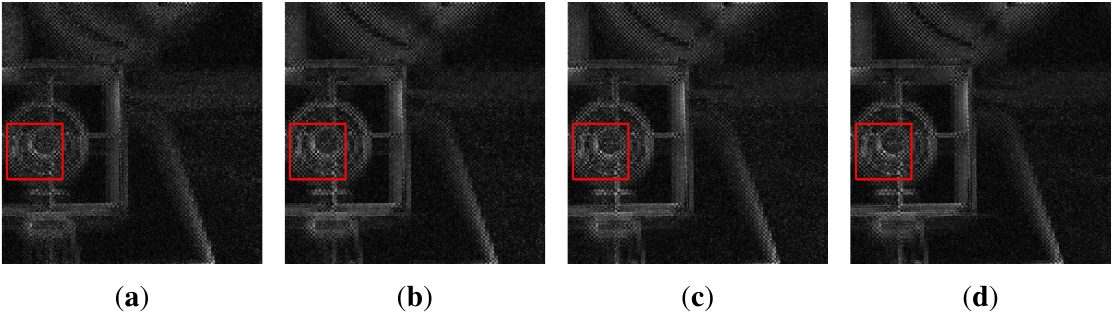
Figure 16. Results of the feature extraction of the left-phase images of Figure 15: ( a ) the 5 lux feature image with ISO-3200; ( b ) the 40 lux feature image with ISO-2000; ( c ) the 70 lux feature image with ISO-1000; and ( d ) the 100 lux feature image with